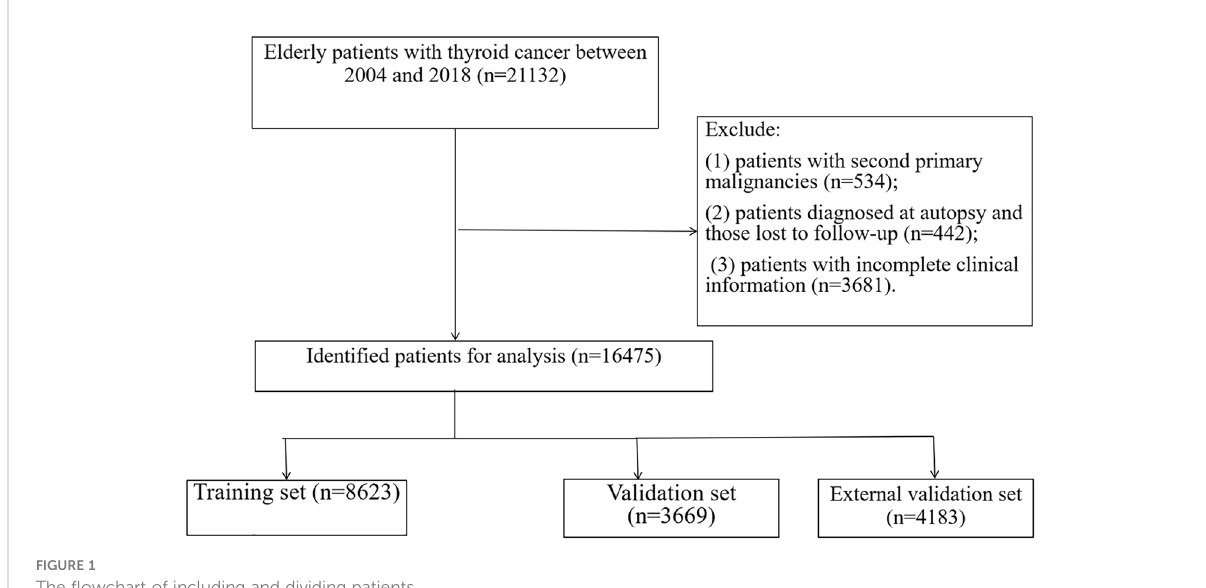
FIGURE 1 The fl owchart of including and dividing patients.